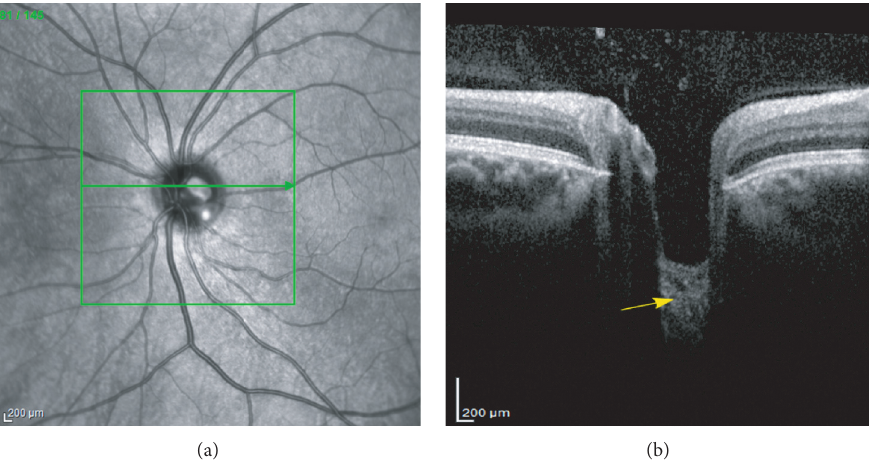
Figure 1: Retinal fundus photograph (a) and EDI-OCT B-scan at the optic nerve head (b). The green line denotes the location of the B-scan in the fundus image. The yellow arrow points to the lamina cribrosa